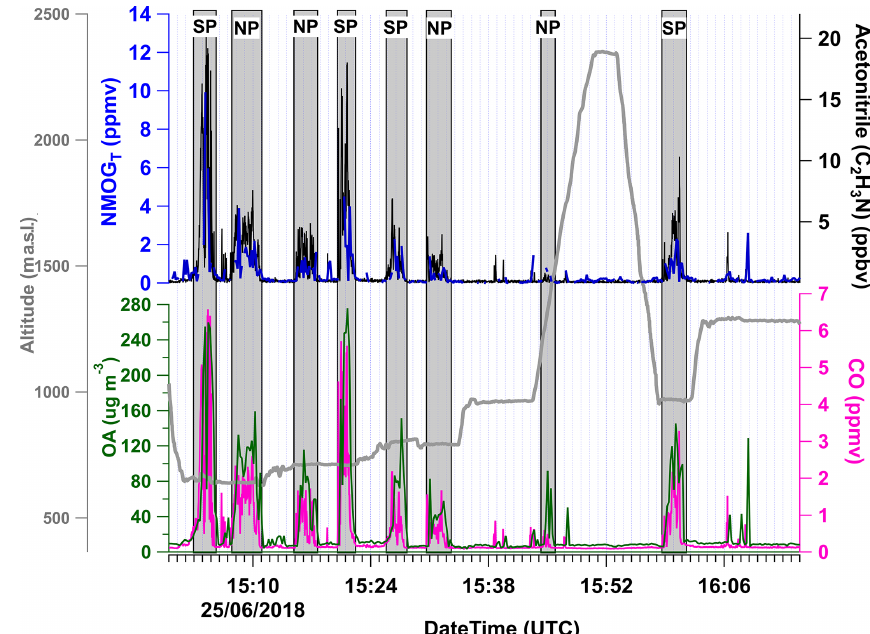
Figure 3. Time series of NMOGs T (ppmv), acetonitrile (C 2 H 3 N; ppbv), and CO (ppmv), and OA concentrations (µgm − 3 ) and altitude for screen 1. The in-plume portions are indicated by the vertical grey bars. The aircraft flew back and forth across the plumes at increasing altitudes to complete five transects; a transect represents one pass across the SP and NP at the same